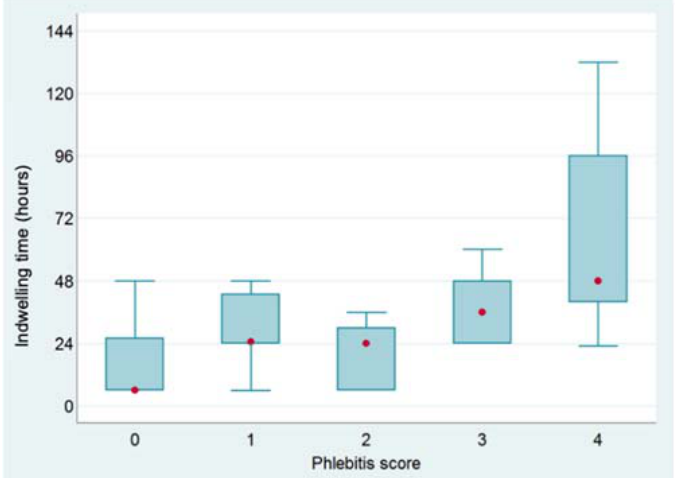
Figure 2. Box plot of indwelling time of catheters according to variations of phlebitis scores in dogs (red circles indicate the median values of the distributions).